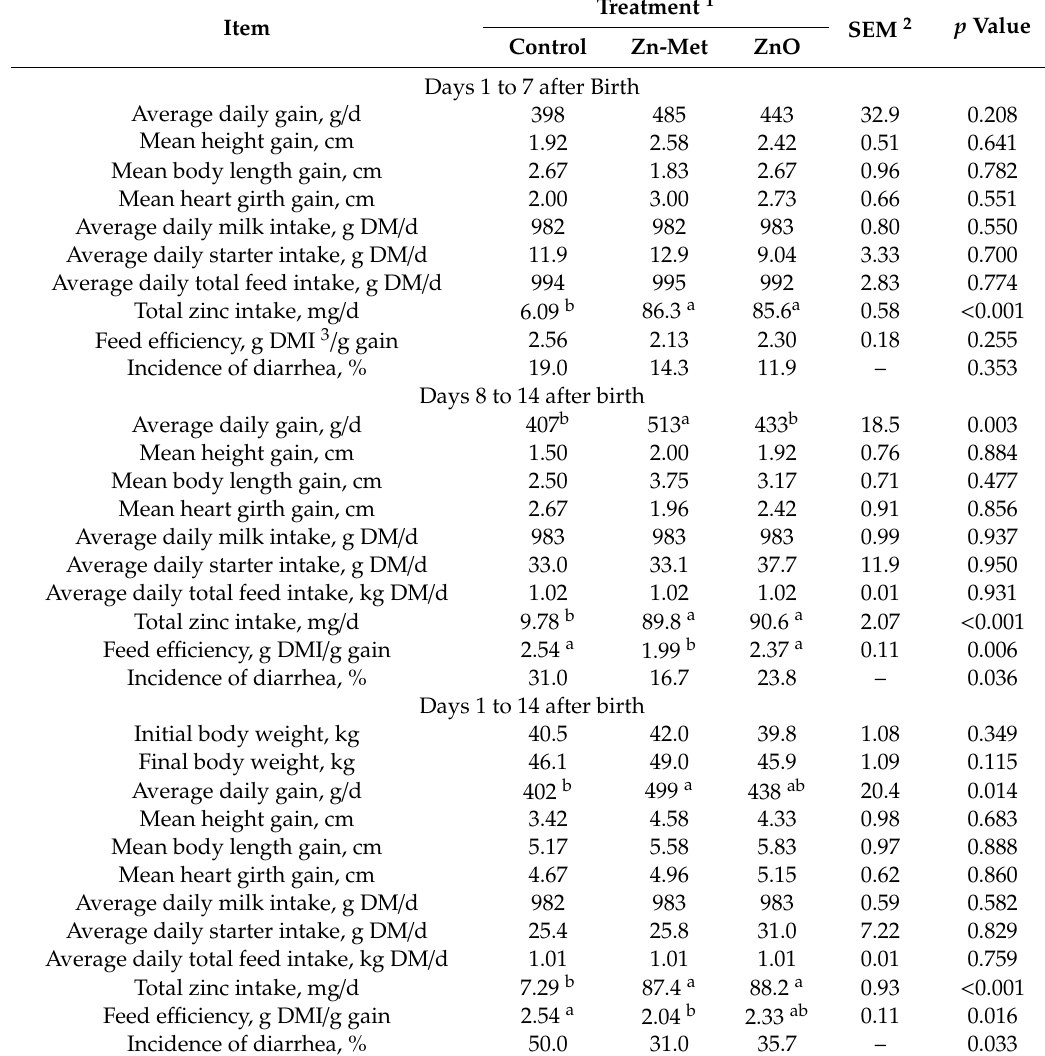
Table 3. E ff ects of zinc methionine (Zn-Met) and ZnO on the growth performance and incidence of diarrhea in Holstein dairy